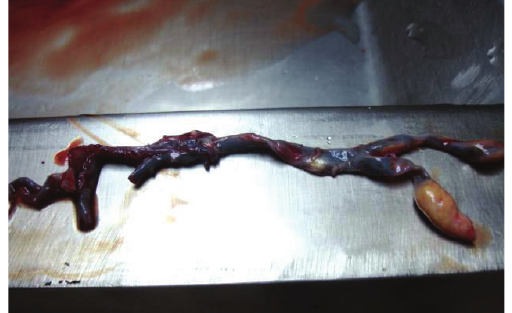
Figure 2: The occlusion of the basilar artery involved mainly the median portion. Note the atheromatous basilar artery, with an extensive and fresh thrombus.